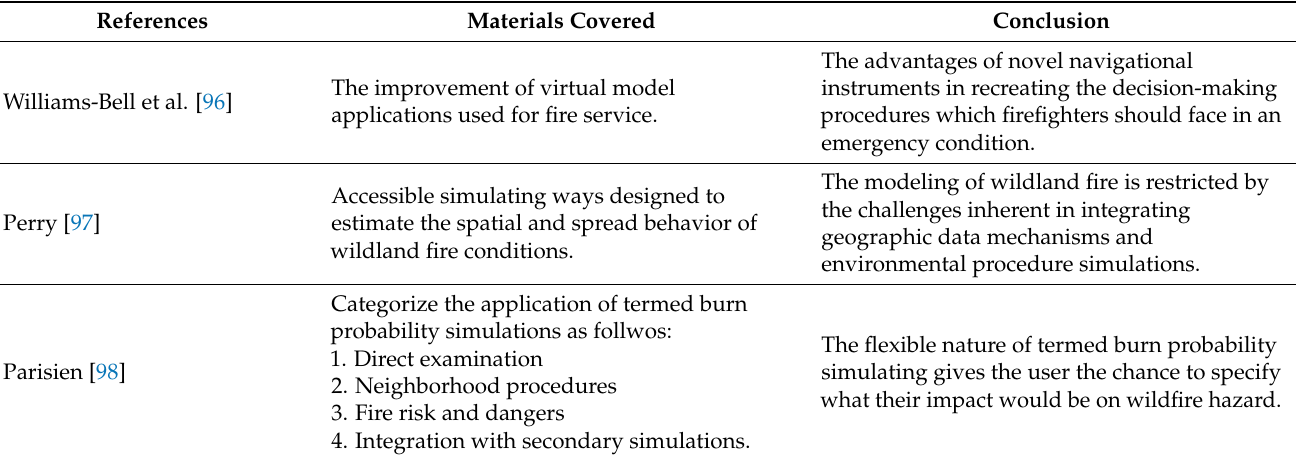
Table 3. Existing reviews on fire spread modeling and wind-fire